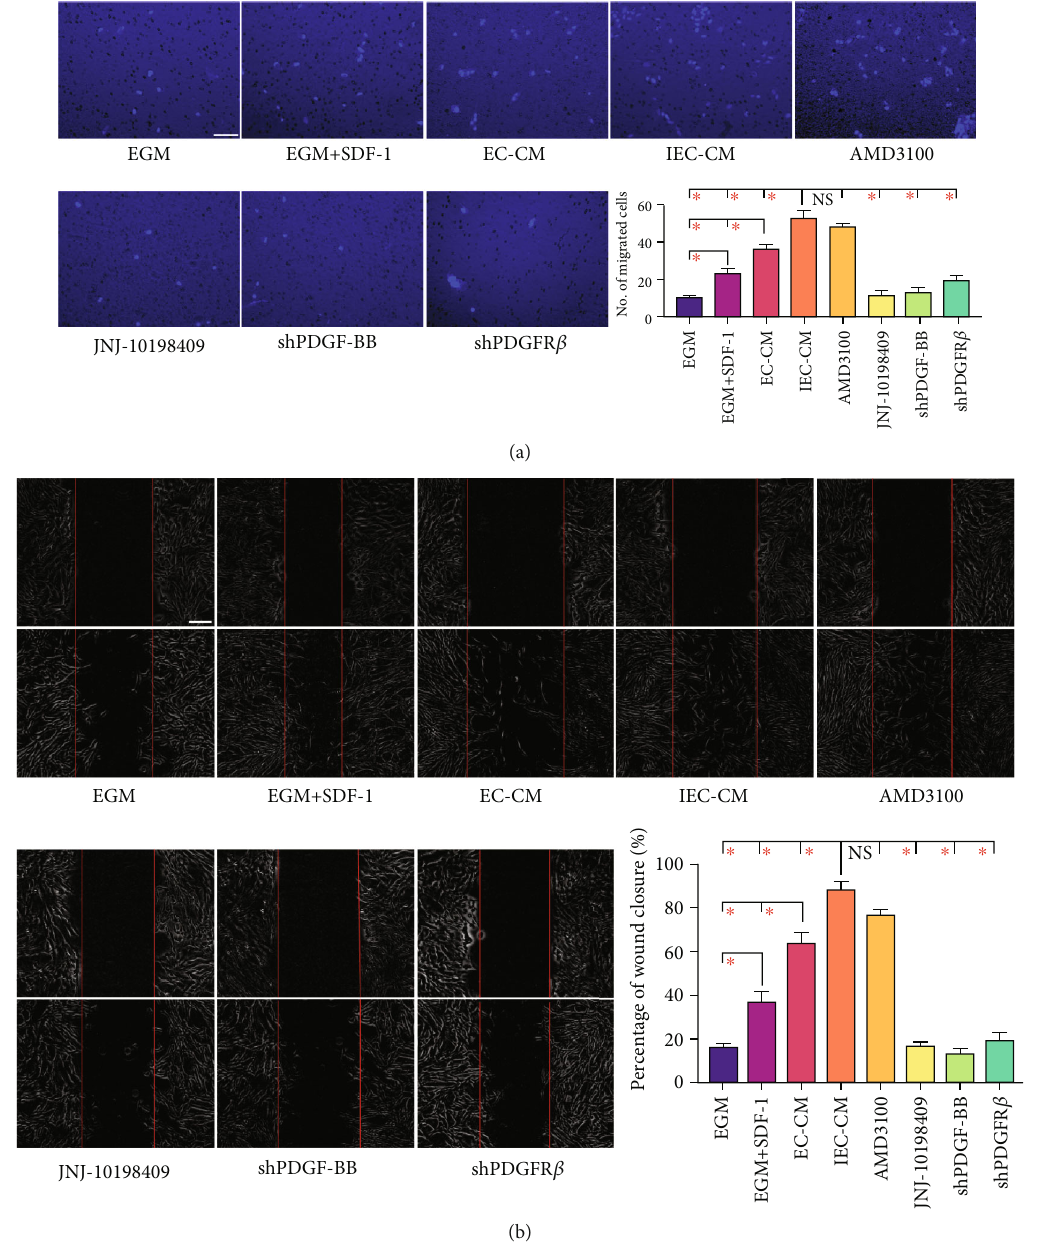
Figure 1: MSCs migrated toward ECs via PDGF-BB/PDGFR β in the in fl ammatory microenvironment. (a) Representative images of migrated hBMSCs that had received di ff erent pre-treatments or had been exposed to di ff erent inducing media. The migration capacity of hBMSCs was determined using a Transwell culture system. The quanti fi cation of migrated cells was shown as a bar graph. Scale bar, 50 μ m. ∗ P < 0 : 05 . (b) Representative images of wound healing assays. The rate of scratch wound closure was shown as a bar graph. Scale bar, 200 μ m. ∗ P < 0 : 05 . EGM: endothelial cell growth medium-2. EC-CM: conditioned media of endothelial cells. IEC-CM: conditioned media of endothelial cells in the context of in fl ammatory microenvironment; shPDGF-BB: short hairpin RNA targeting pdgfb ; shPDGFR β : shRNA targeting pdgfrb